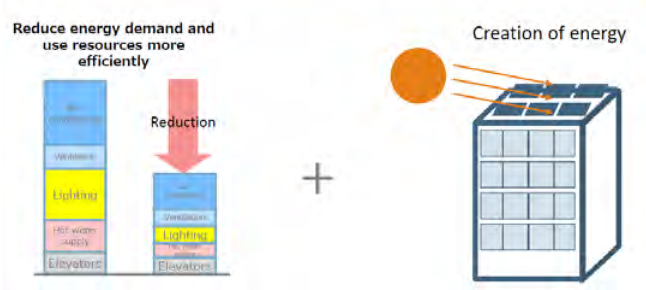
Figure 2. Generating Energy from renewable sources(EECDA,2015)